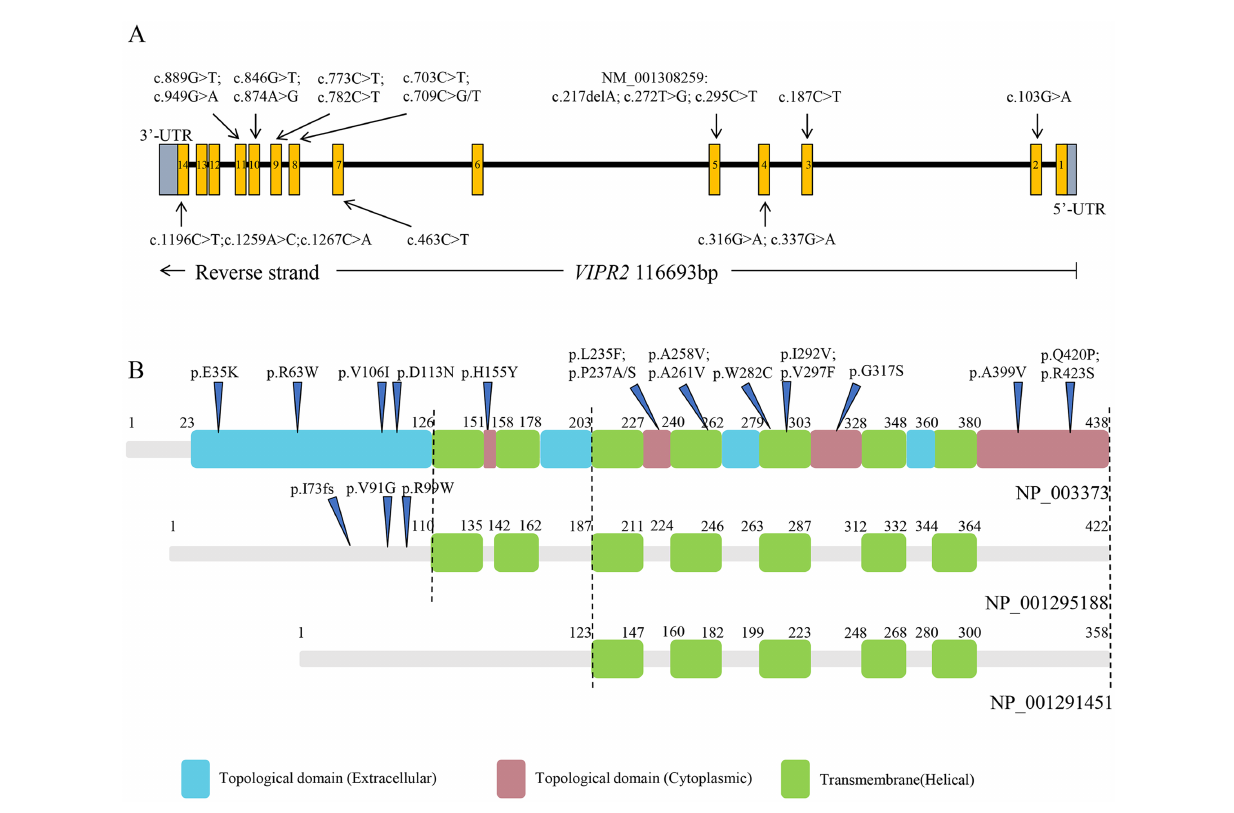
FIGURE 1 Structure of VIPR2 gene and VPAC2 isoforms. (A) VIPR2 gene structure, boxes 1 ~ 14 indicate the protein-coding exons. (B) VPAC2 isoforms structure based on NP_003373, NP_001295188, and NP_001291451.